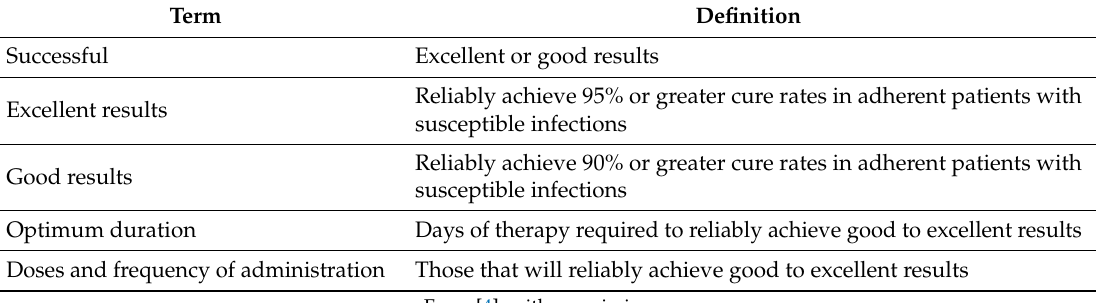
Table 1. Definitions of terms to describe outcome of